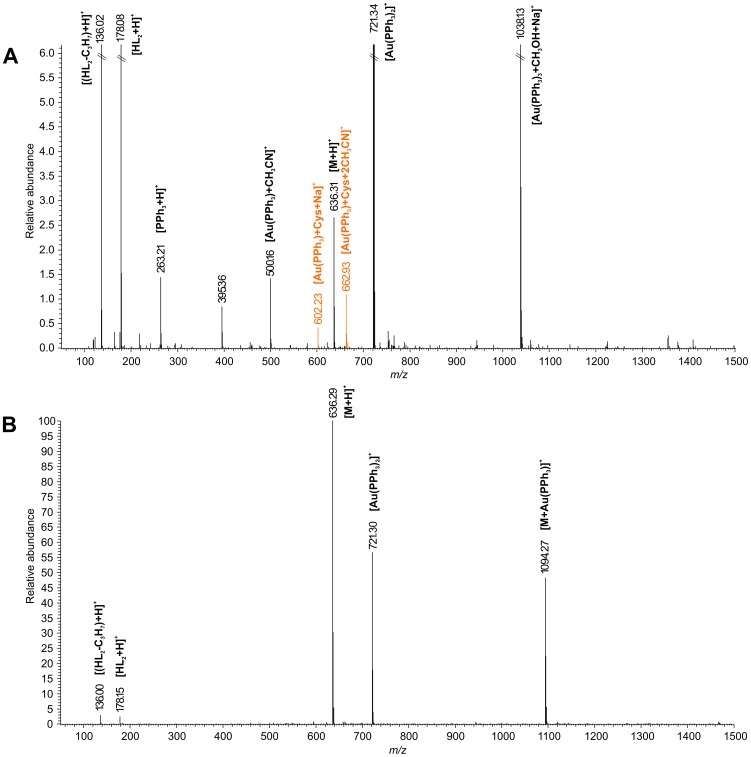
ESI+ MS spectra of the interacting system containing cysteine + glutathione + complex 2 in the water/methanol (1∶1 v/v) mixture (A), and the solution of complex 2 in the water/methanol (1∶1 v/v) mixture (B).